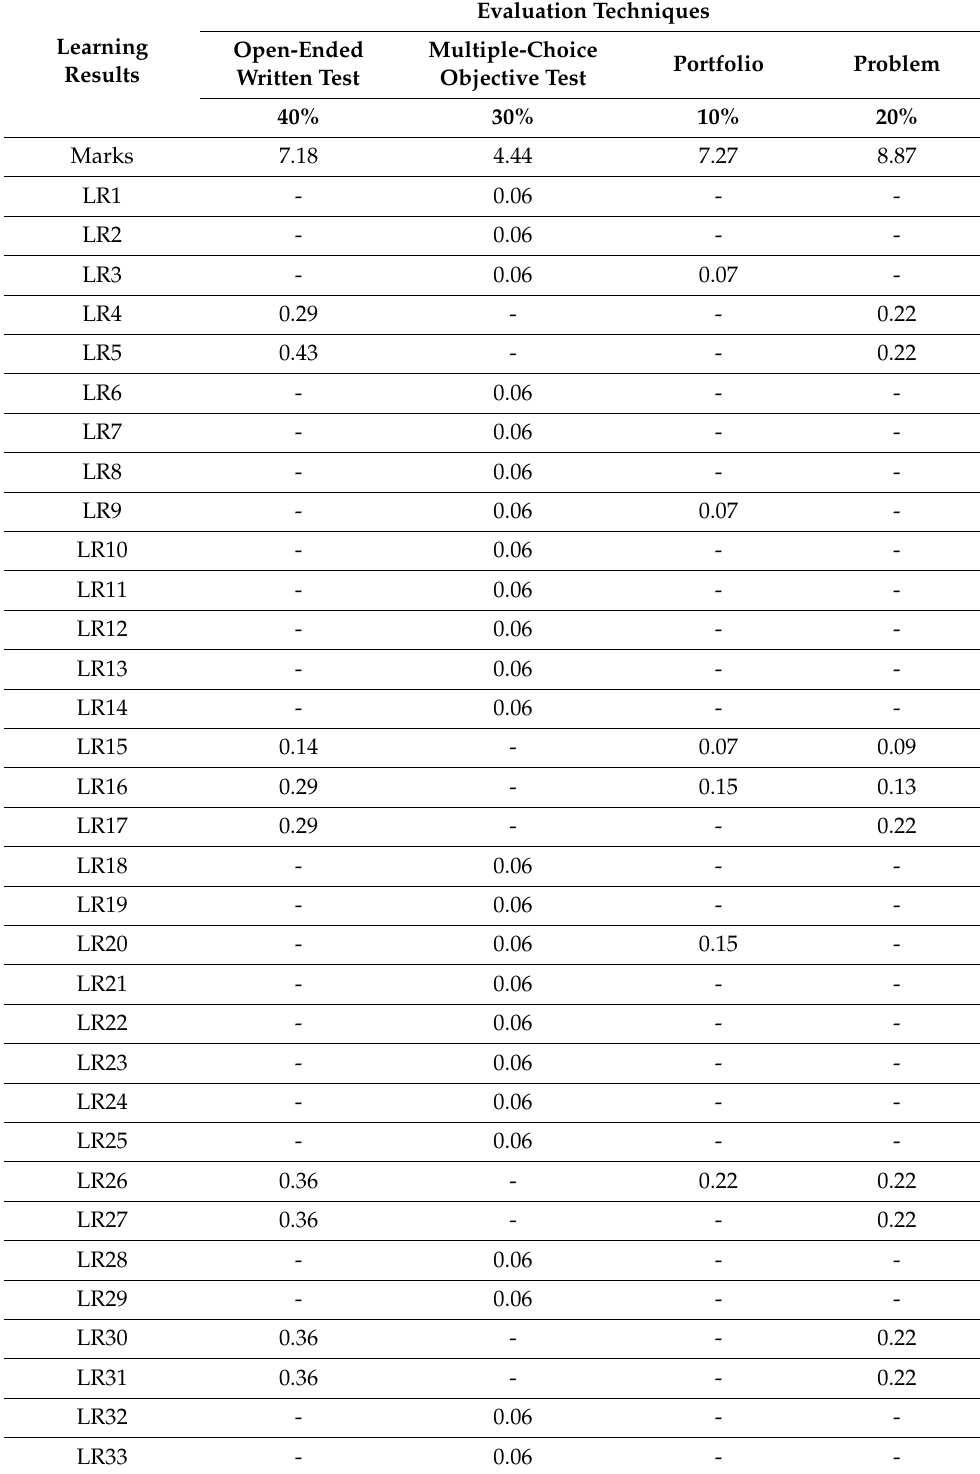
Table 6. Evaluation matrix of the course on energy